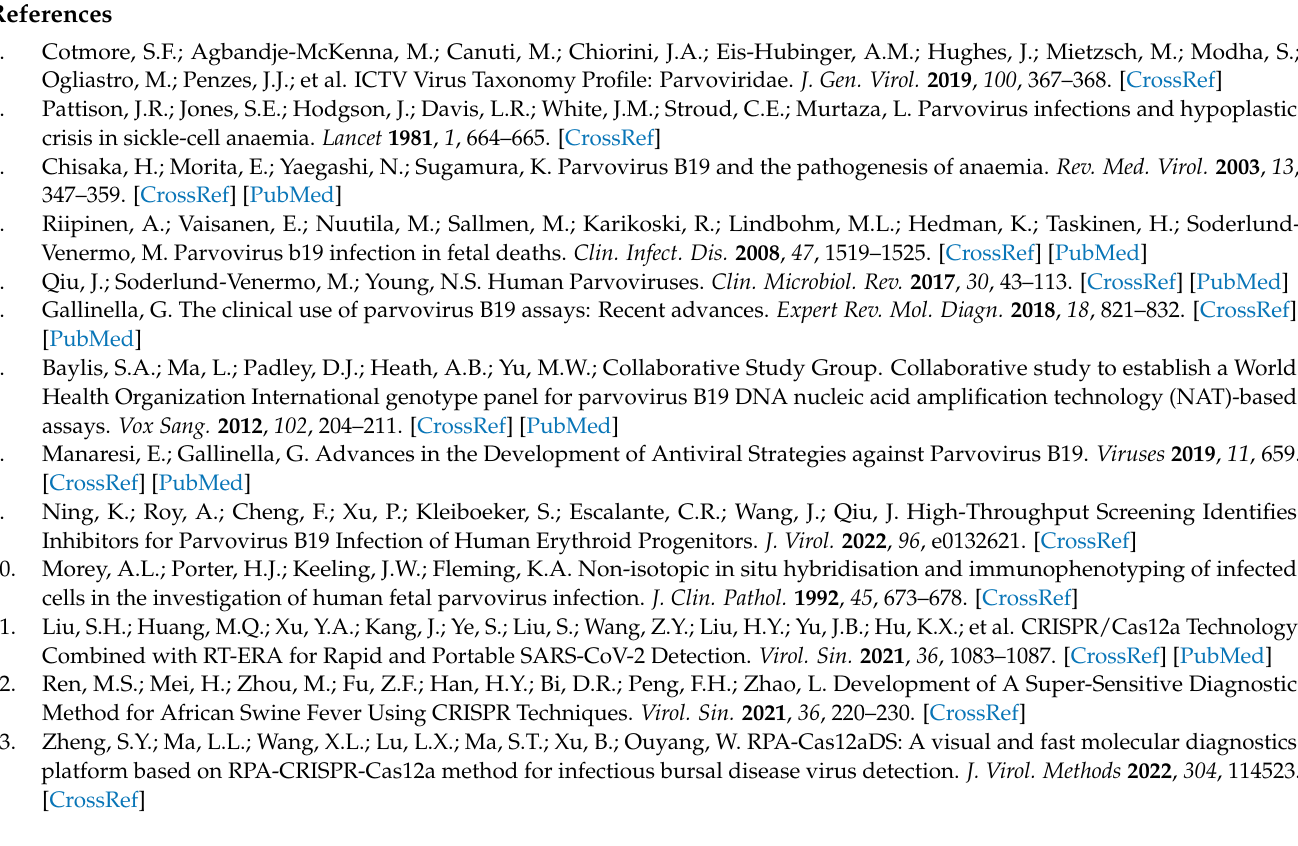
detection system. Figure S3, A–C. Establishment of the B19-NS1 PAND with one single gDNA system. Figure S4, A–C. Analysis of clinical samples by B19-NS1 PAND coupled with nested PCR.; Table S1, Oligonucleotides and primers used in this